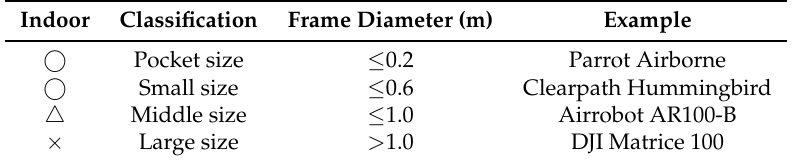
Table 1. Definition of a quadcopter class